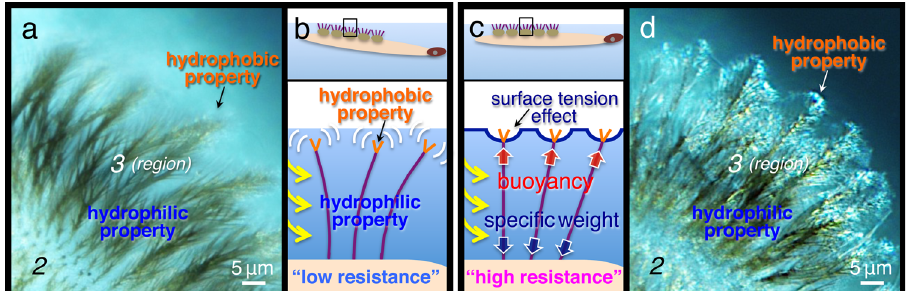
resistance condition during larval locomotion. a , d High-magni fi cation differential interference microscopy images of the tips of the hairy crown structures and b , c schematic drawings. Image of the fl exible hairy structures away from the water surface in a and b . Note that, with this condition, the hydrophobic hairy structures are unable to resist the water fl ow (yellow allows). When the hydrophobic hairy tips are attached to the water surface, both ends of the hairy structures are pulled by the surface tension and the speci fi c weight of the larva in c and d . These fi xed hydrophilic hairy structures produce high resistance against water fl ow during